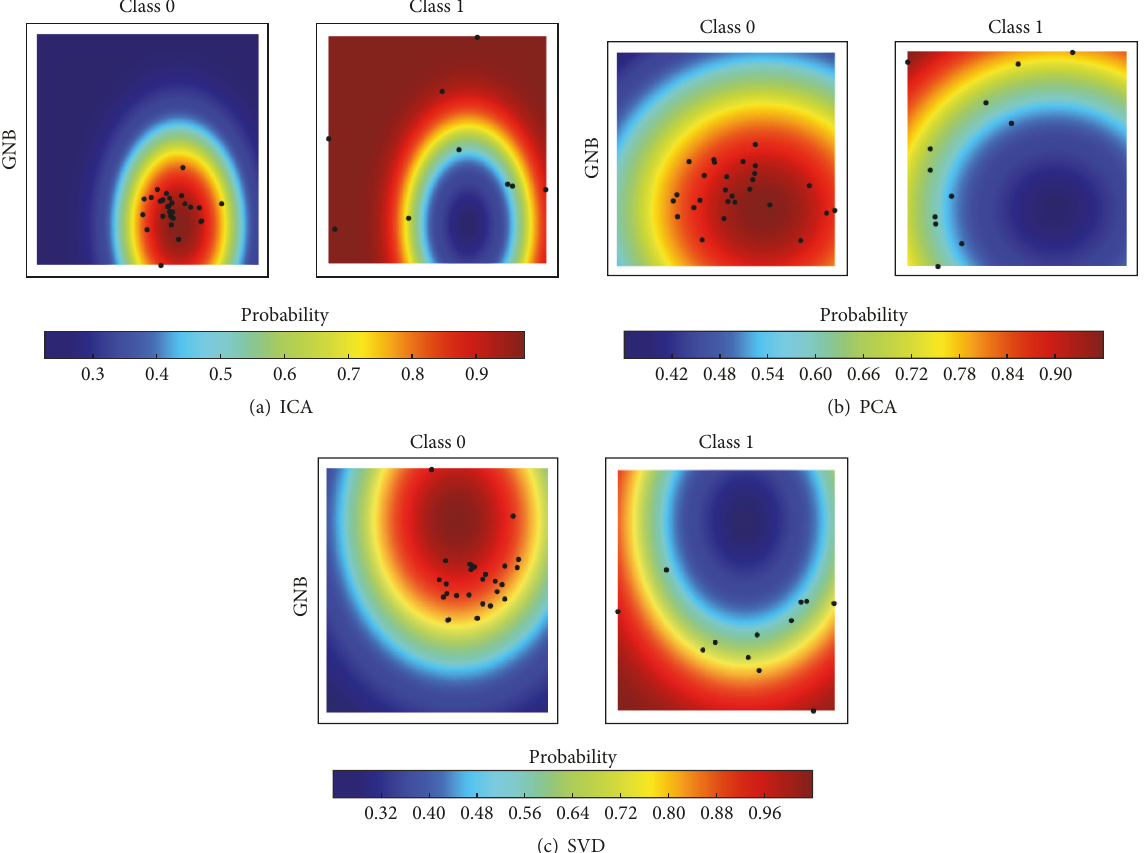
Figure 9: Contour plots of probability surface for classification using the Gaussian Naive-Bayes for ICA, PCA, and SVD data reduction